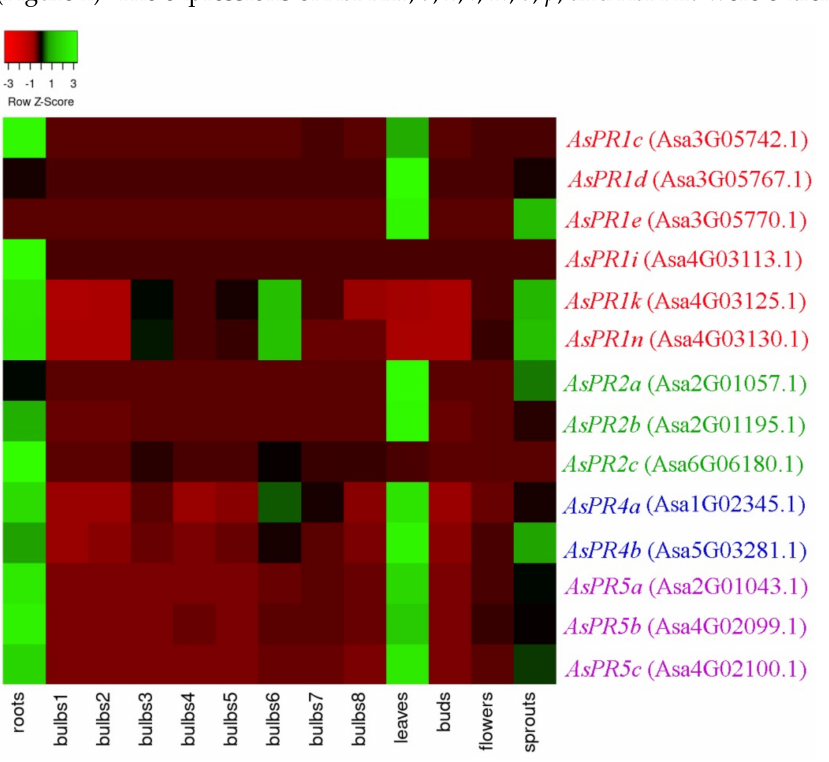
Figure 2. Expression heatmap of PR genes in Allium sativum cv. Ershuizao (GSE145455). The mRNA expression of AsPR1 (red), AsPR2 (green), AsPR4 (blue), and AsPR5 (purple) in the roots, bulbs (1, 2, 3, 4, 5, 6, and 7 correspond to 192-, 197-, 202-, 207-, 212-, 217-, 222-, and 227-day-old bulbs, respectively), leaves, buds, flowers, and sprouts. The color scheme indicates the gene expression gradient from low (red) to high